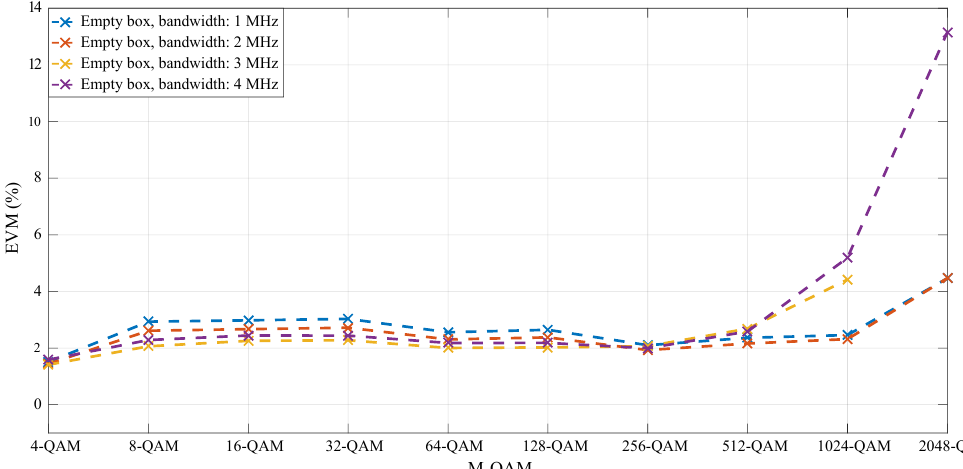
Figure 17. EVM/distance relationship for Octavia tail-light with different M-QAM and bandwidths—in scenario 1—empty box.